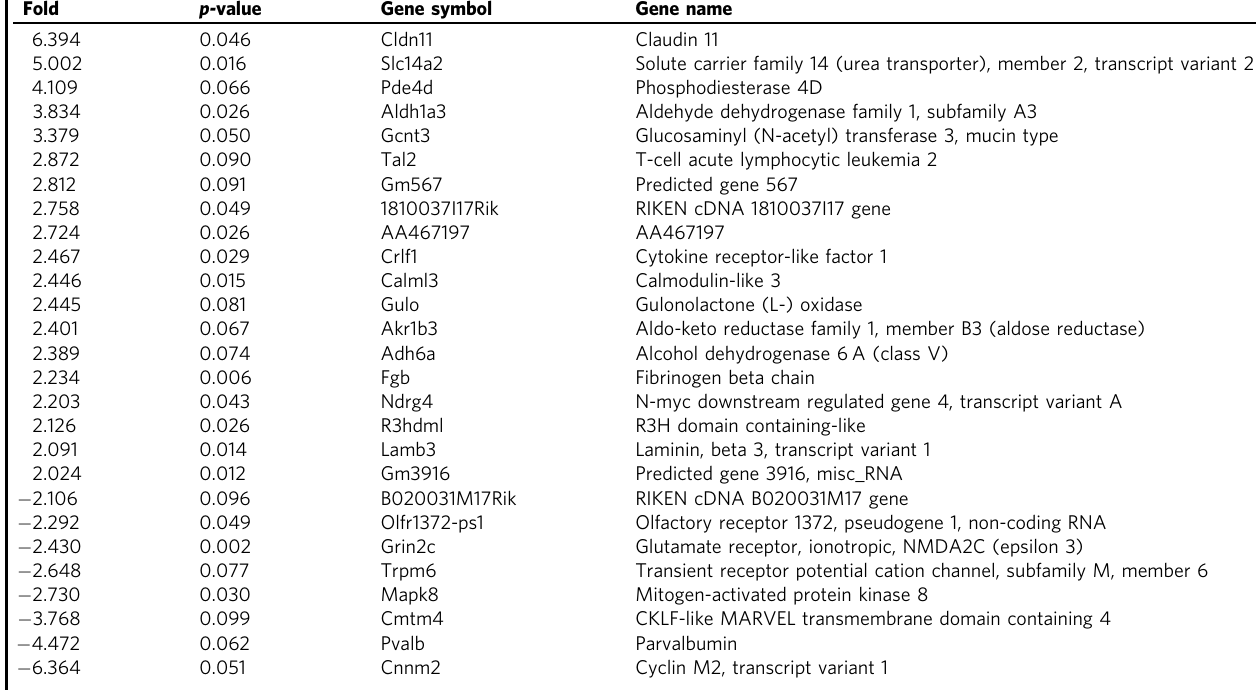
Table 1 Genes that were upregulated or downregulated in the kidneys of Cnnm2 fl / fl ; Six2-Cre mice. Fold p-